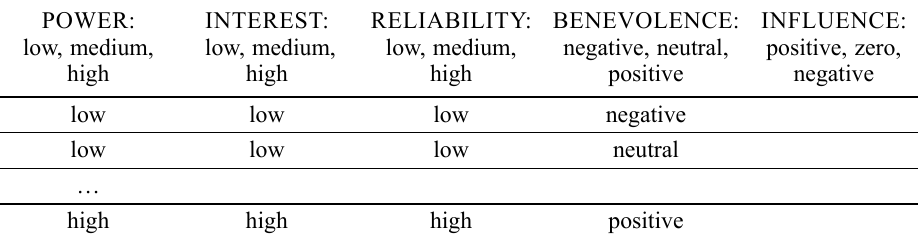
Fig. 3. The fuzzy system Source : created by authors. Table 1. Qualitative knowledge about stakeholdersinflunce on the enterprise “H” under variuos combinations of power, interest, reliability and benevolence